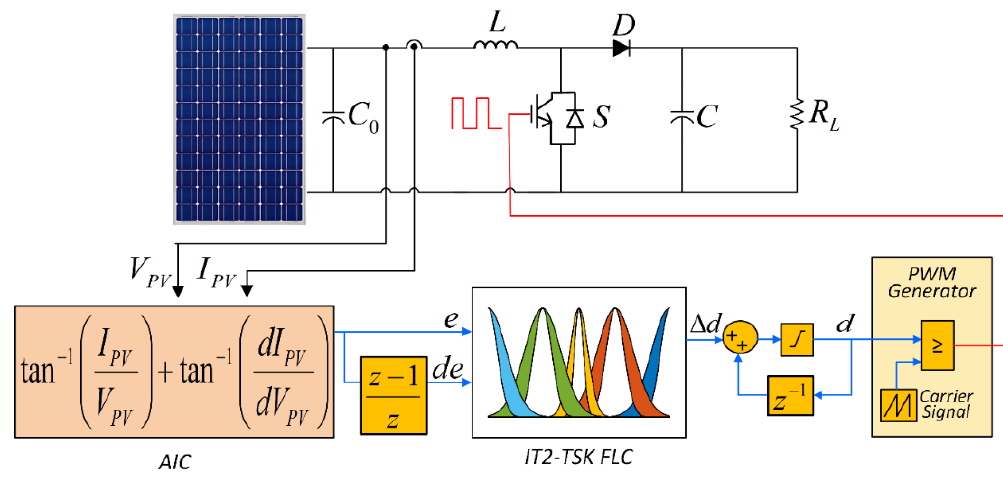
Figure 2. Proposed hybrid control structure.